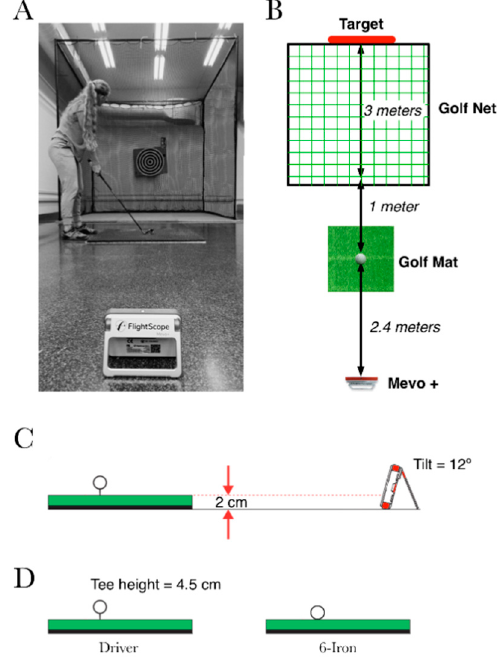
Figure 1. Experimental setting. ( A ) picture from the back of the experimental setting in the lab is shown in layer ( A ). Layer ( B ) presents a top view of the setting with the distances between the Mevo+, the golf mat, the golf net and the target. In layer ( C ), a lateral view of the Mevo+ is shown, as well as the height difference between the sensor and the golf mat and the tilt of the Mevo+. Finally, in layer ( D ), the positions of the ball on the golf mat during the driver and six iron shots are shown.